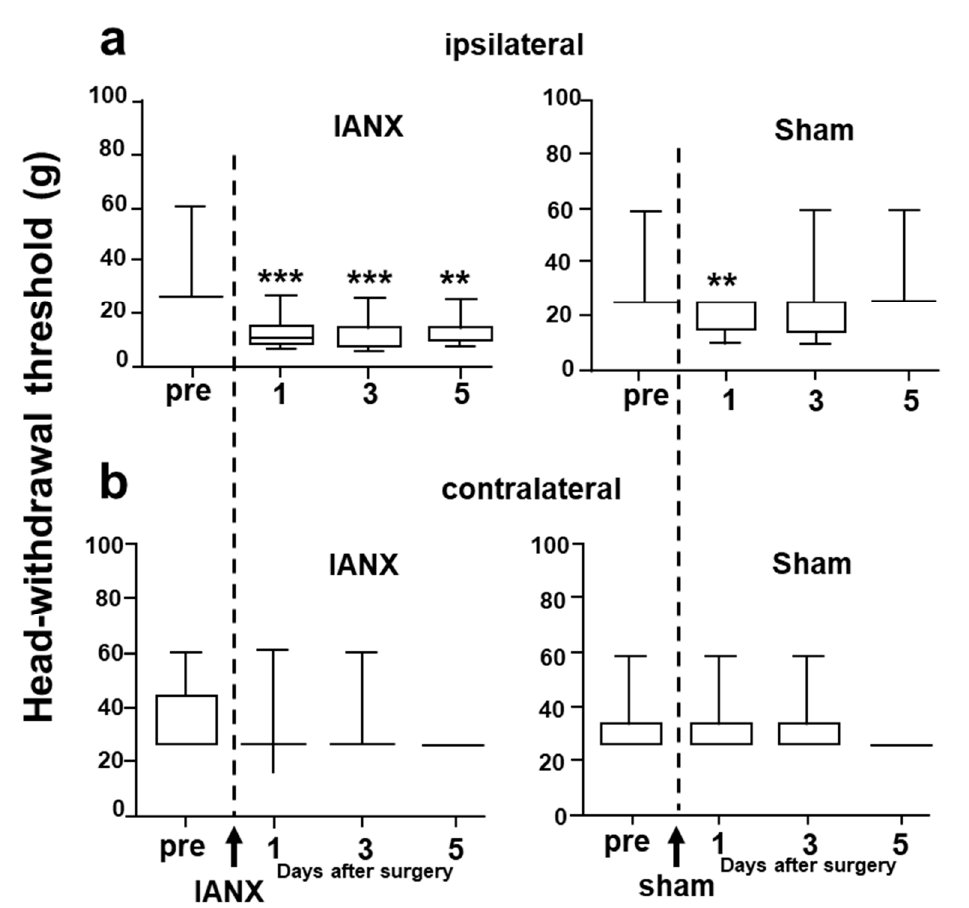
Figure 1. Head-withdrawal threshold to mechanical stimulation of the whisker pad skin in inferior alveolar nerve transection (IANX) and sham rats. ( a ): Ipsilateral side, ( b ): contralateral side. pre: before IANX or sham surgery, After: after IANX or sham surgery. ***: p < 0.001, **: p < 0.001 (pre vs. after). n = 7 in each group.